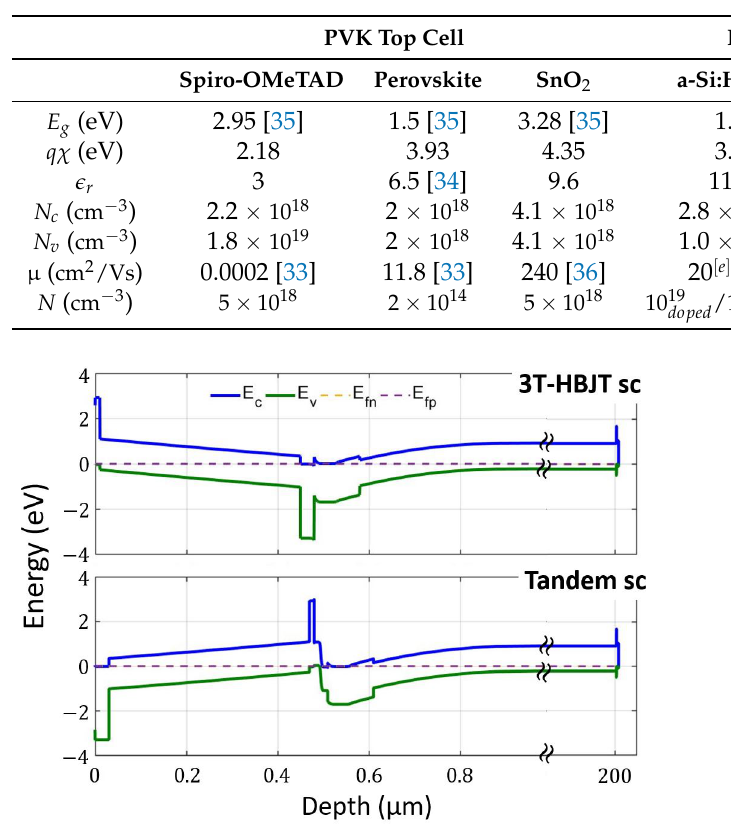
Table 1. Main parameters value. E g : Bandgap χ : Electron affinity (cid:101) r : Permittivity N c ( N v ) : Density of states µ : Mobility τ : Lifetime. ( e / h ): electron/hole; if not specified, the shown value is the same for both carriers.